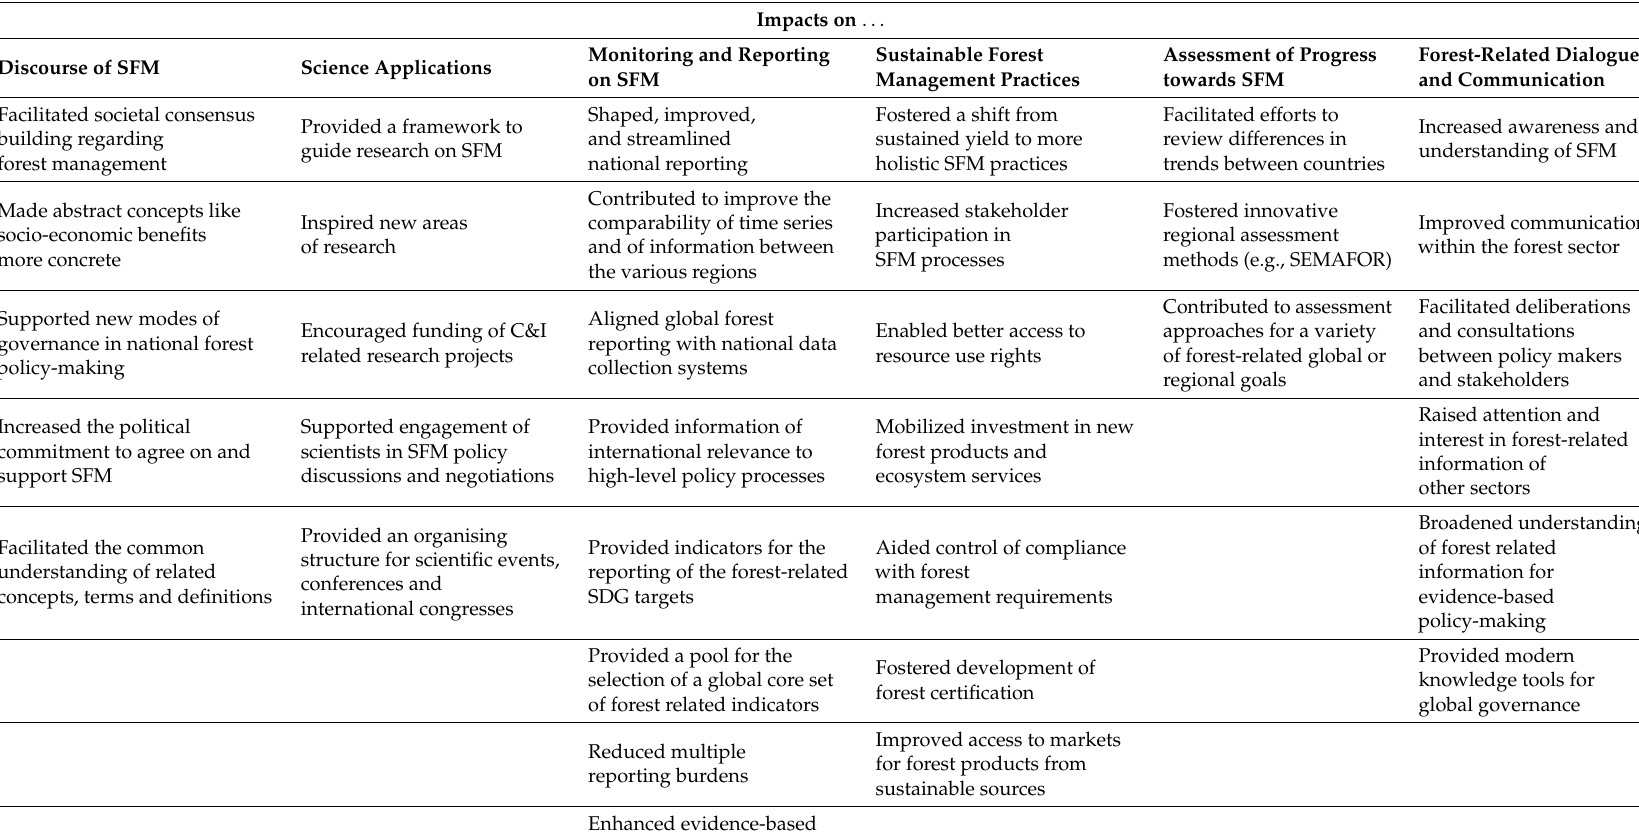
Table 1. Summary of the major impacts of intergovernmental, regional, and international C&I processes and their respective sets. Impacts on . .